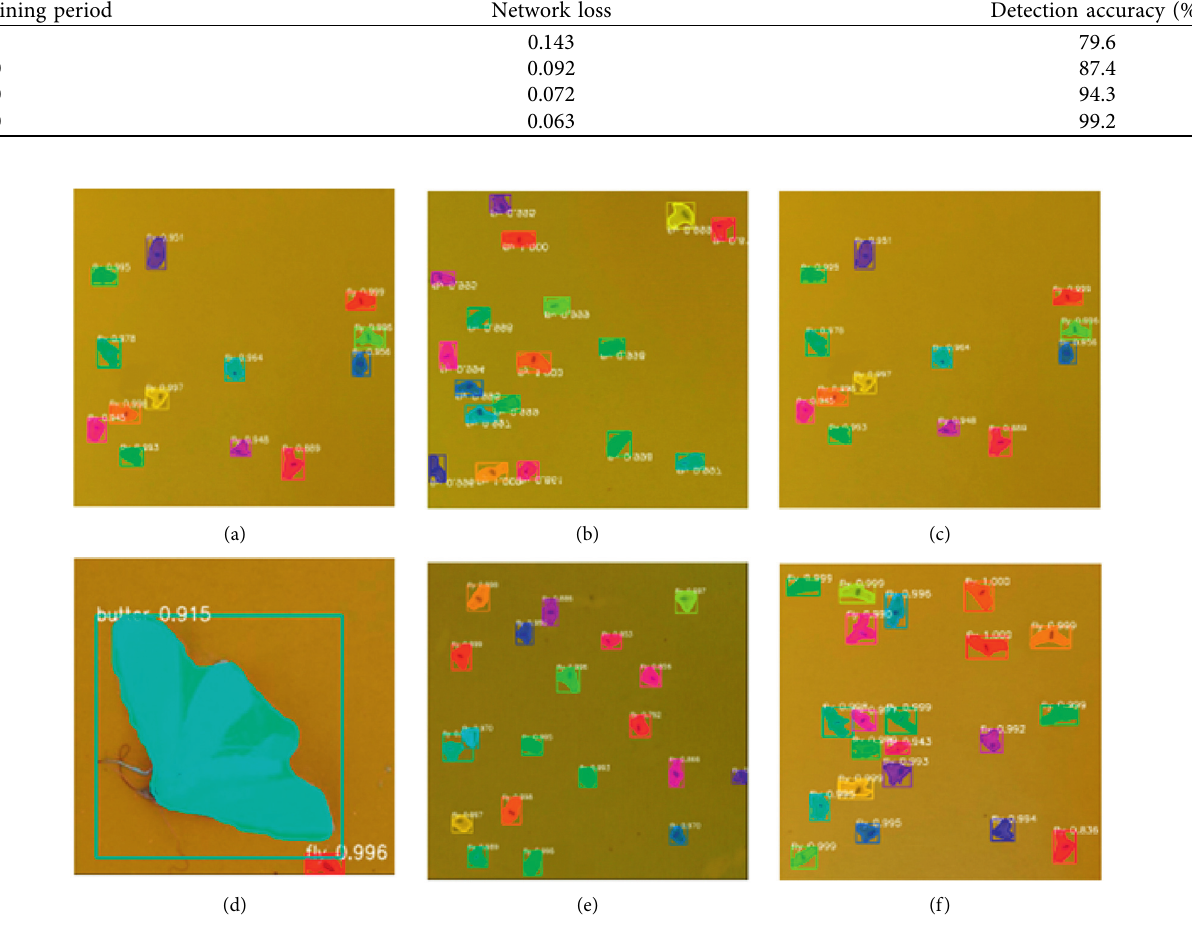
Figure 5: Predict the instance segmentation of the